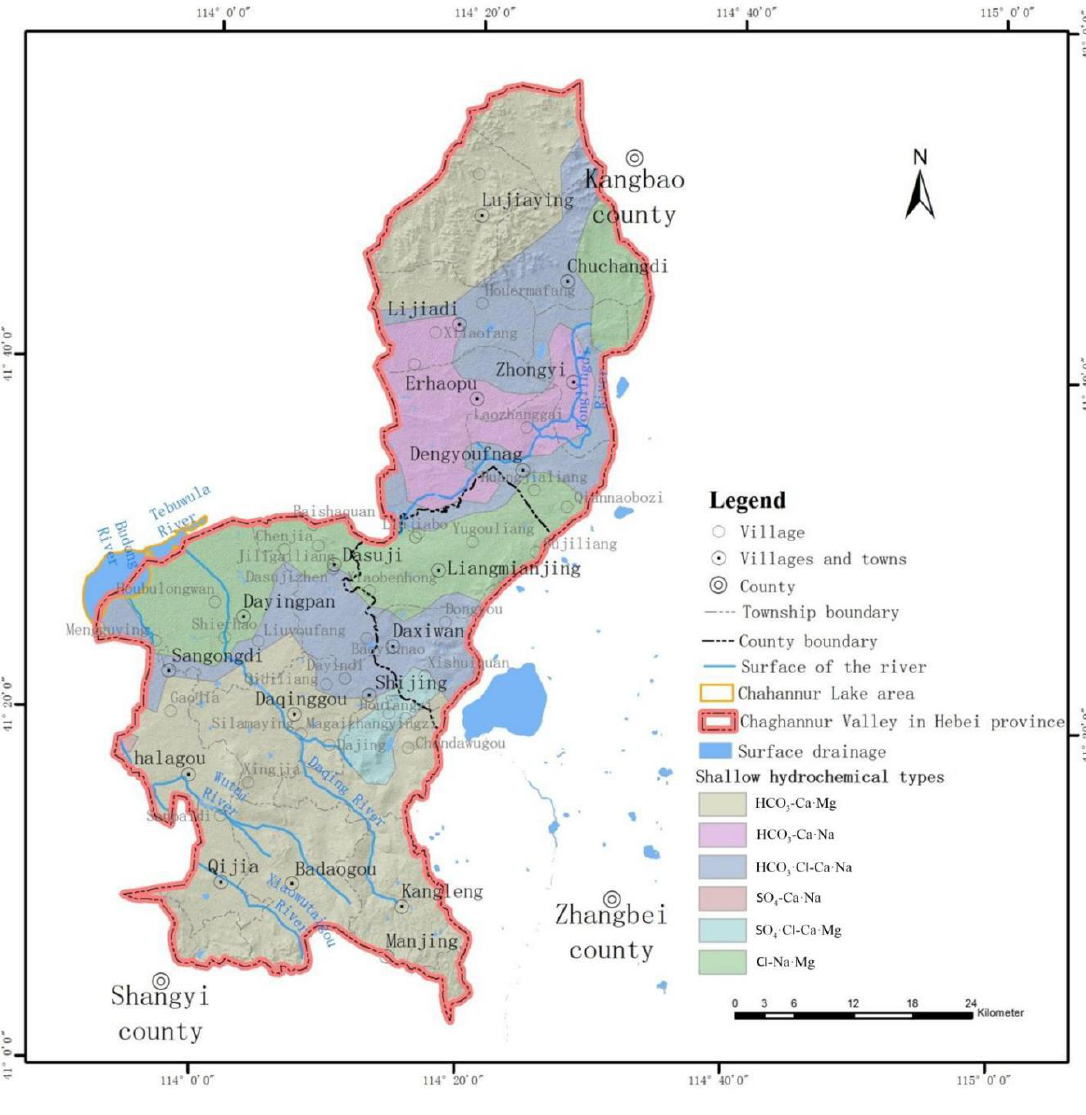
Figure 3. Zoning map of the chemical types of shallow groundwater in the Chahannur Basin.